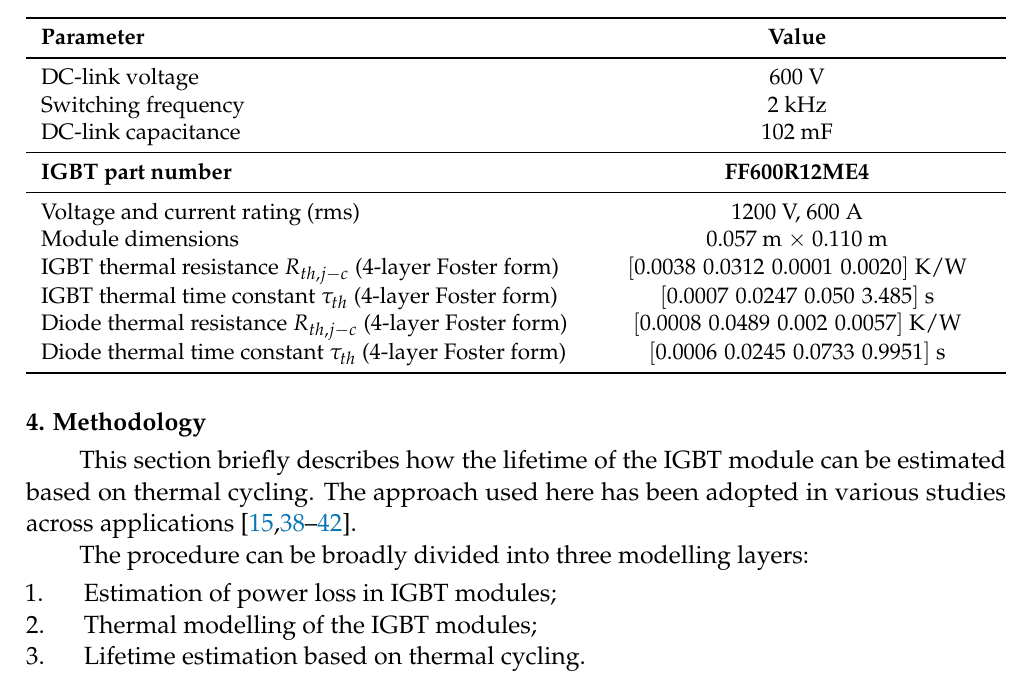
Table 3. Converter parameters.